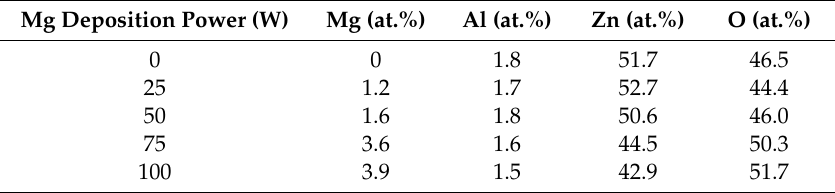
Table 1. Composition of the studied films examined by energy dispersive spectroscopy